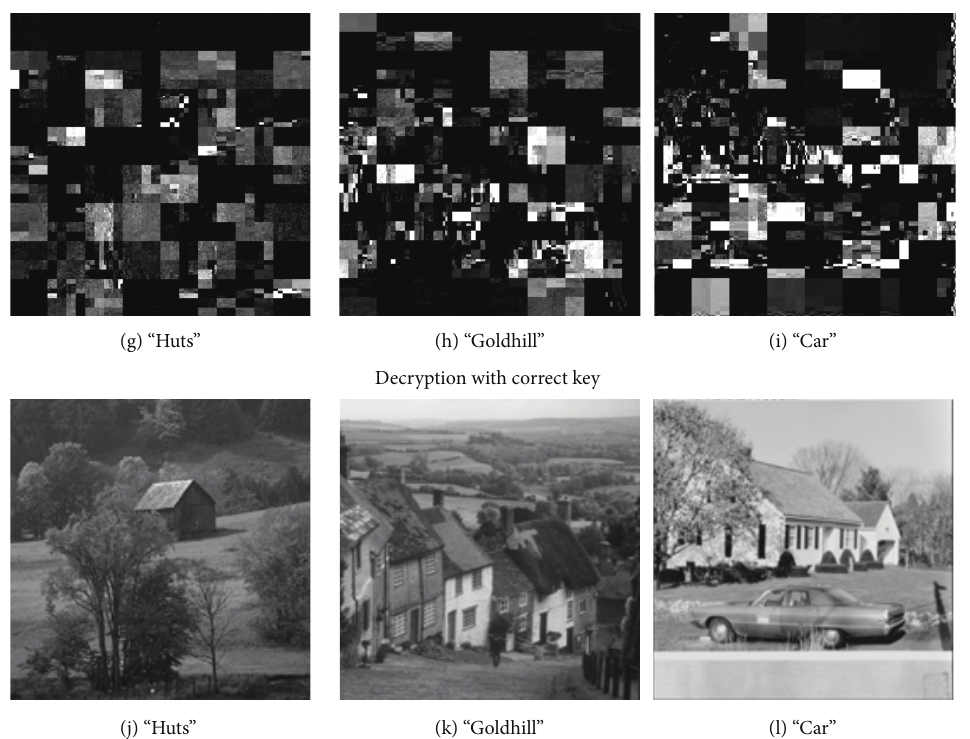
Figure 3: Key sensitivity results for huts, goldhill, and car